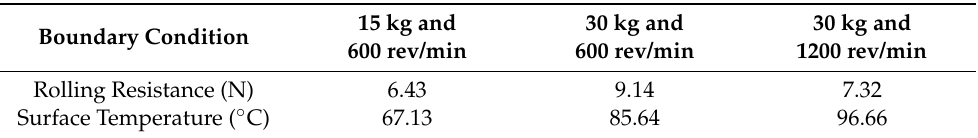
Figure 16. Contour plots of steady-state surface temperature of the Lagrangian–Eulerian finite element tire model under different rolling conditions ( a ) 15 kg and 600 rev/min, ( b ) 30 kg and 600 rev/min, ( c ) 30 kg and 1200 rev/min. Table 3. Simulation data of RR and maximum steady-state surface temperature of the Lagrangian– Eulerian model under different rolling